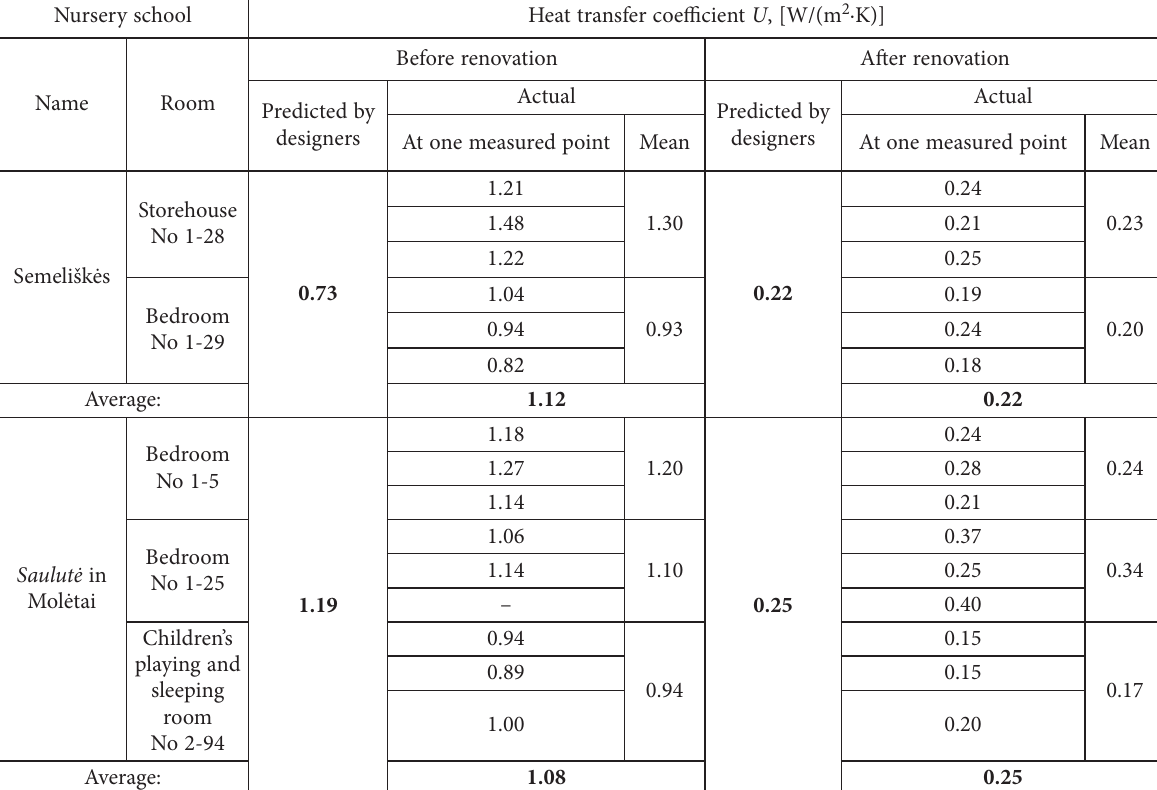
Table 1. Heat transfer coefficients before and after wall